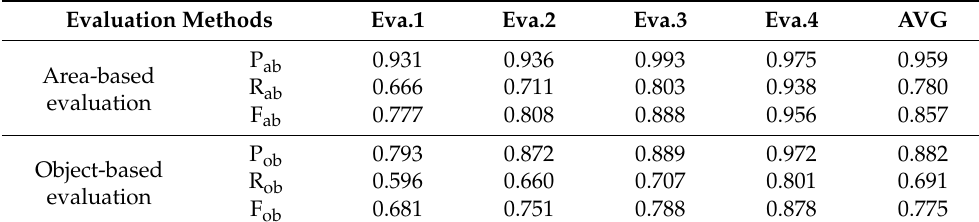
Table 4. Accuracy assessments of tiles in different